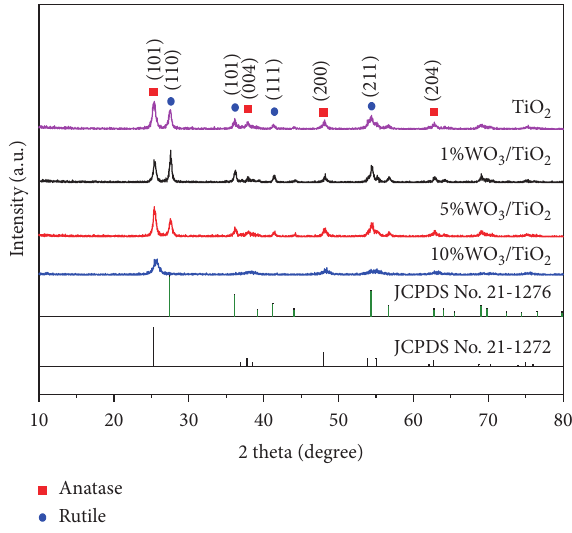
Figure 1: XRD patterns of TiO